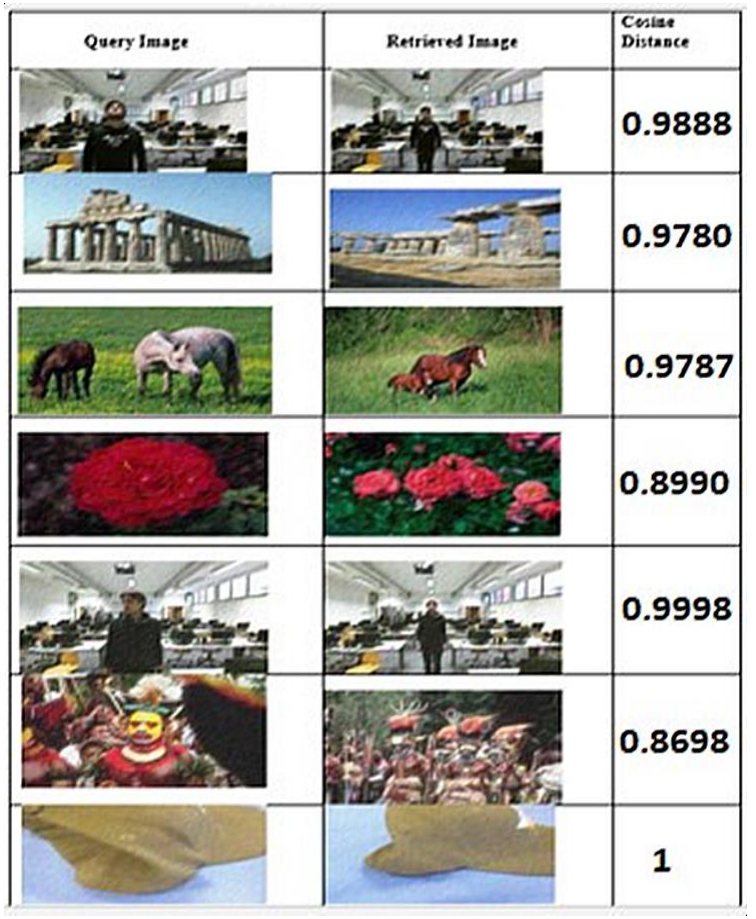
Figure 18. Training process of Sparse Auto-encoder (SAE) in the proposed.